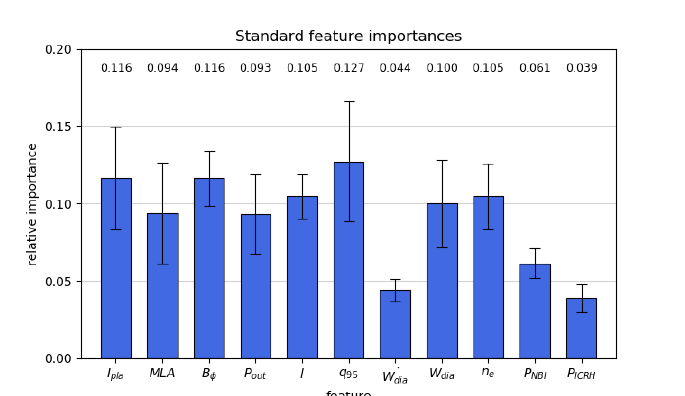
Figure 1. Relative importance of the different standard input features, as obtained from the random forest